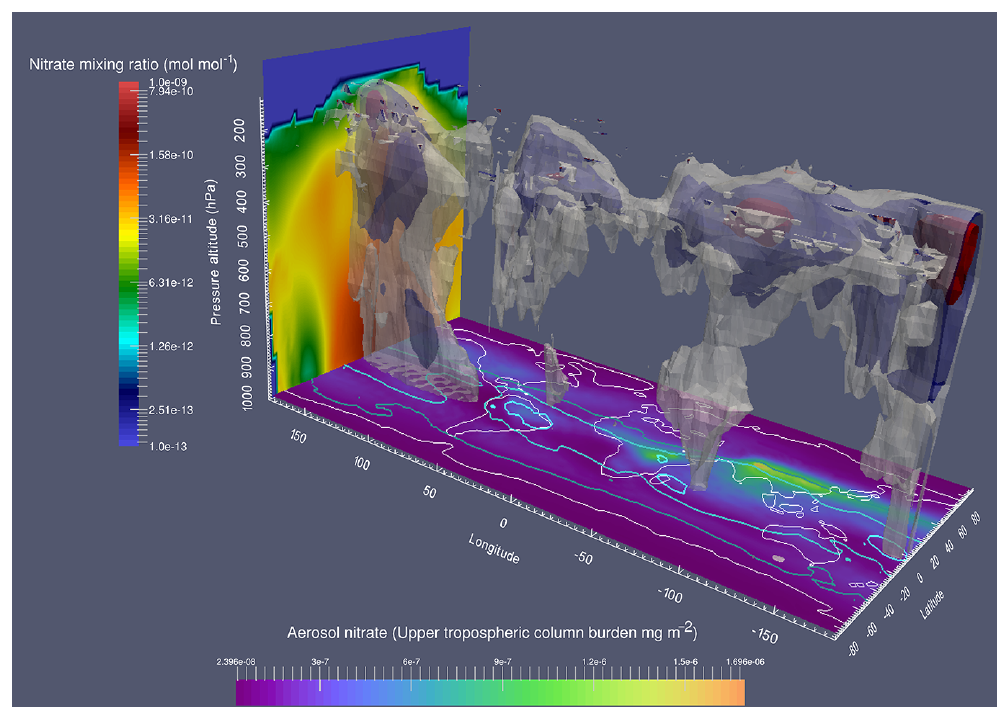
Figure 3. 3-D visualisation of the relative differences in tropospheric aerosol nitrate mixing ratios between the simulations with and without LNO x emissions to the simulation including LNO x emissions. The grey isosurface depicts a relative difference of 30%, the blue isosurface of 45%, and the red isosurface of 60%. Additionally, the upper-tropospheric aerosol nitrate column burden (in mgm − 2 ) between 500hPa and the tropopause is depicted by the coloured panel at the bottom of the graph. The turquoise contour lines depict relative differences of 20, 40 and 60% difference in this column burden between the two